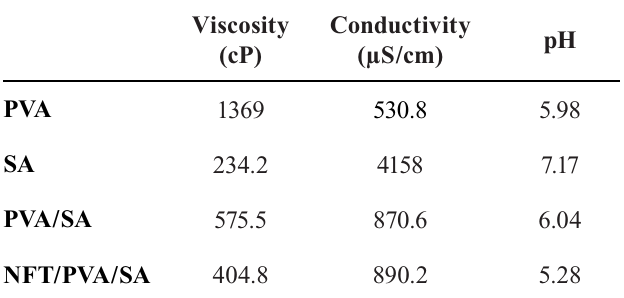
TABLE II - The viscosity, conductivity and pH values of the polymer solutions alone [PVA (16%, w/v) and SA (2%, w/v)], the polymer blend solution (PVA/SA, 8:2), and naftifine containing polymer blend solution (NFT/PVA/SA)